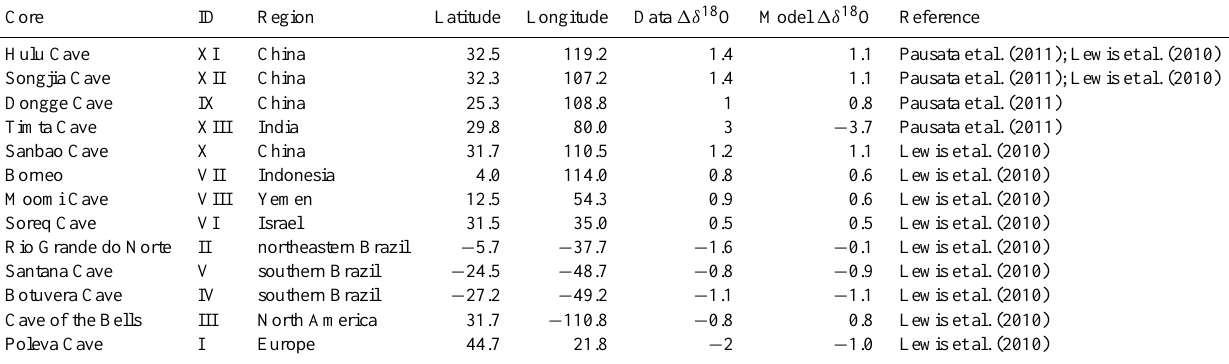
Table 3. Comparison of isotopic proxy records (speleothem’s calcite δ 18 O) with annual average modeled amount-weighted δ 18 O p . Note that anomalies from Pausata et al. (2011) are calculated from H1 and YD, while anomalies from Lewis et al. (2010) arise from all identifiable δ 18 O c